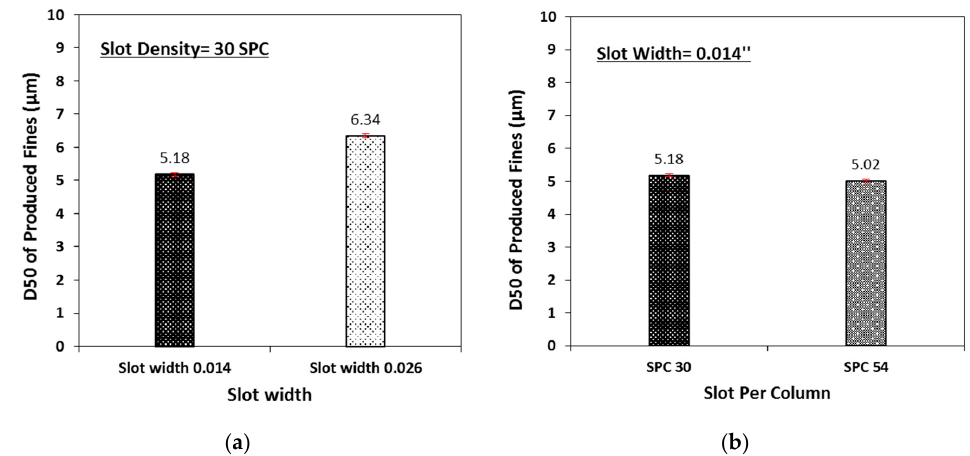
Figure 11. ( a ) Effect of slot width on concentration of fines near the liner, ( b ) effect of slot density on Figure 11. ( a ) E ff ect of slot width on concentration of fines near the liner, ( b ) e ff ect of slot density on concentration of fines near the screen. concentration of fines near the screen.